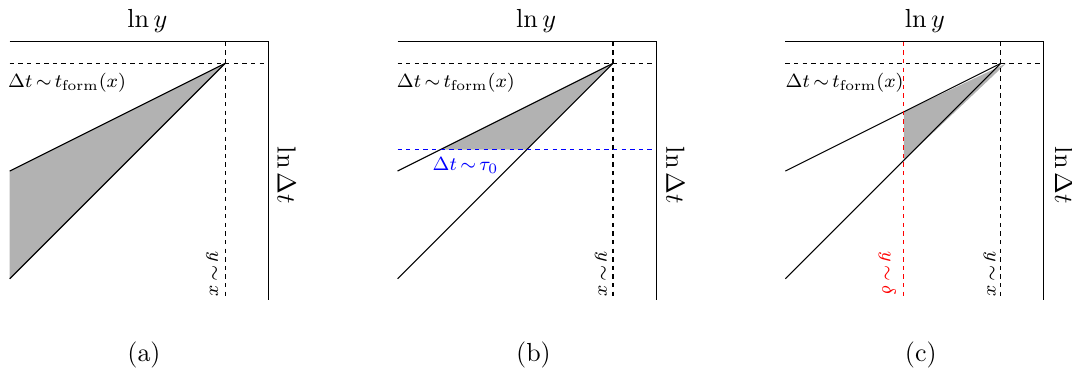
Figure 1 . The region of integration (1.1) giving rise to a double log in the ˆ q approximation with (a) no cut-off, (b) the cut-off ∆ t ∼ τ 0 used in earlier literature, and (c) the IR regulator y ∼ δ used in our calculations. See text for discussion. Above, t form ( x ) ∼ with a single splitting E → x, (1 − x ) E